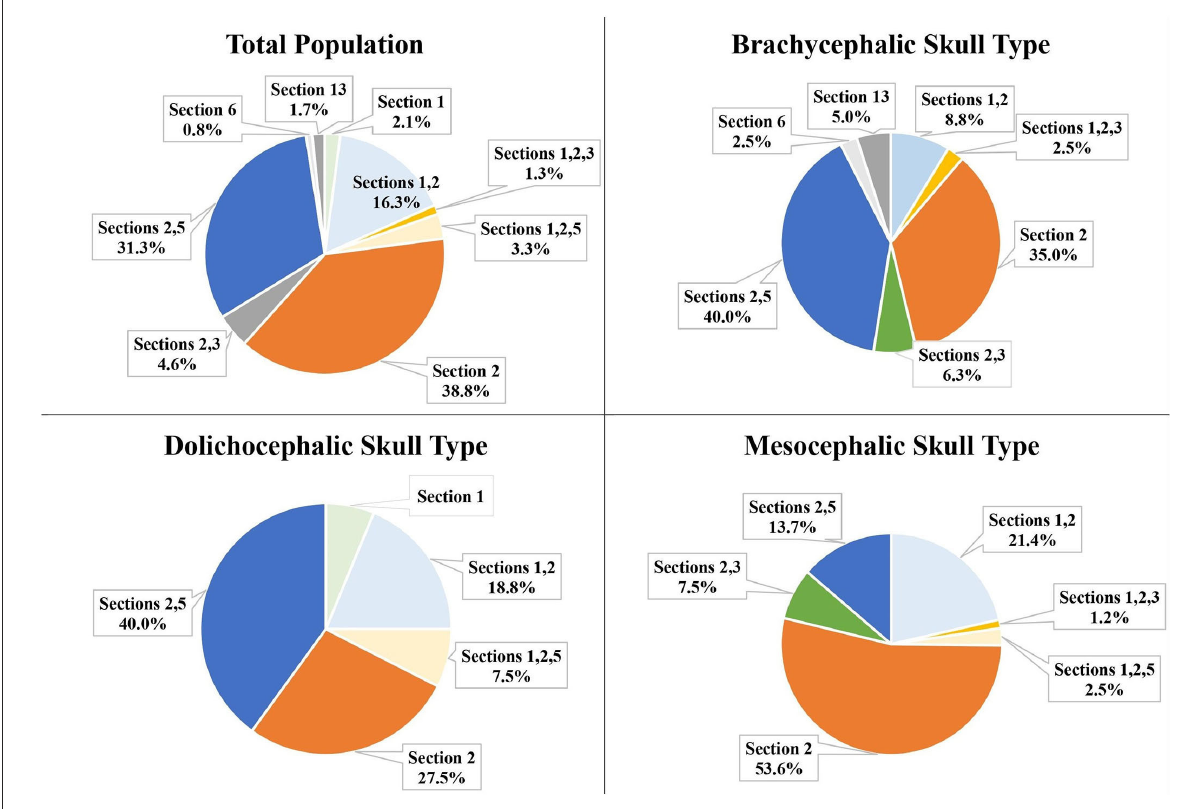
FIGURE6 Position of the IOC and Section 13 relative to the mesial roots of the P4 for the total population and the three different skull types.